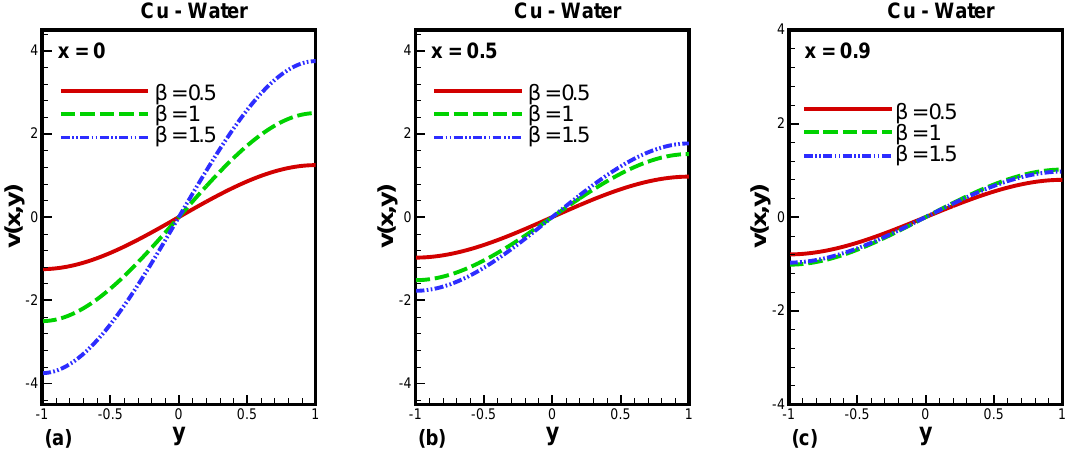
Figure 9. Effect of β on dimensionless transverse velocity at the ( a ) entrance, ( b ) middle, and ( c ) exit regions of the channel, when φ = 0.05, δ = 0.2, and γ = 0.2.